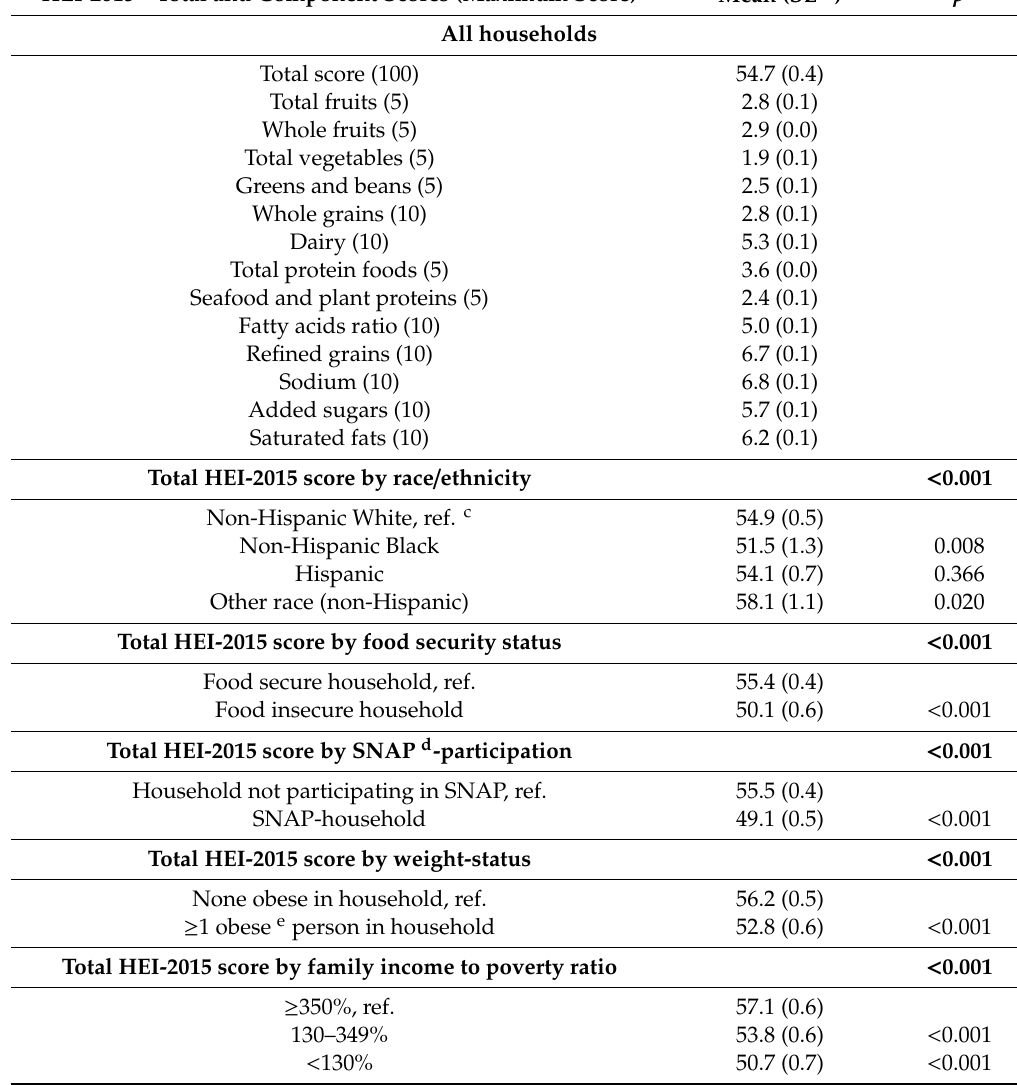
Table 2. Unadjusted mean Healthy Eating Index 2015 total and component scores of food-at-home purchases of households participating in the National Household Food Acquisition and Purchase Survey 2012–2013, overall and according to household characteristics ( n = 3961). HEI-2015 a Total and Component Scores (Maximum